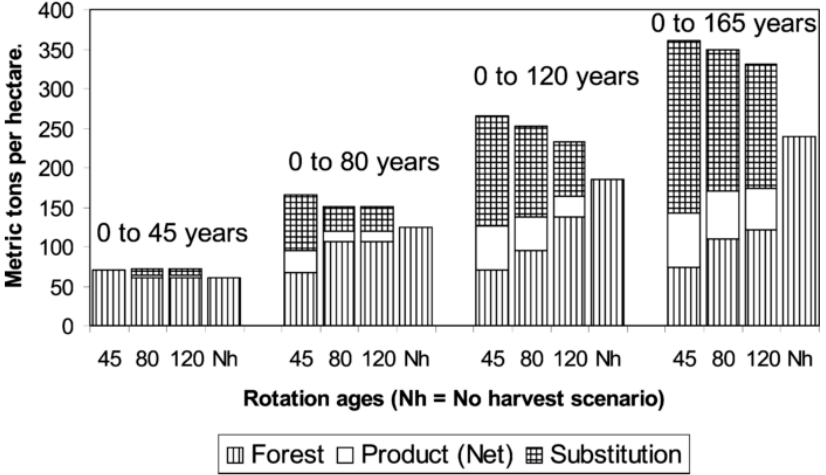
Figure 1. Average annual carbon in forest, product, and concrete substitution pools for different rotations and specified intervals [37].